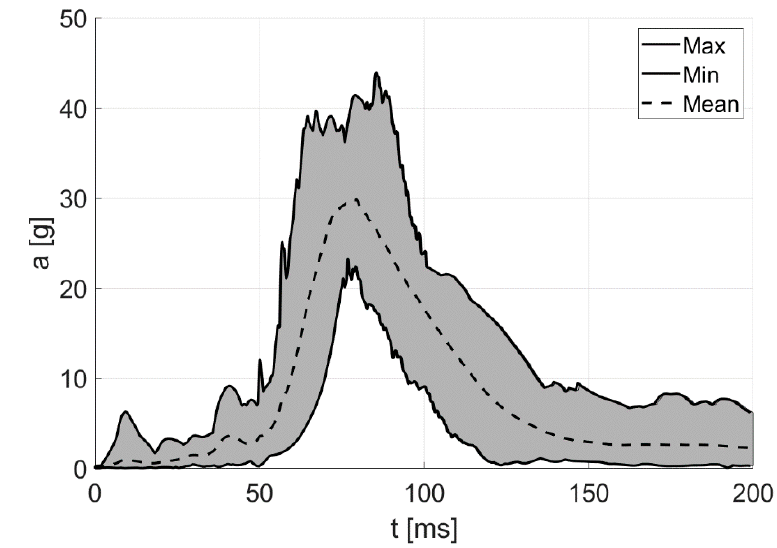
Figure 4. Head COG acceleration for 30 km/h pulse.